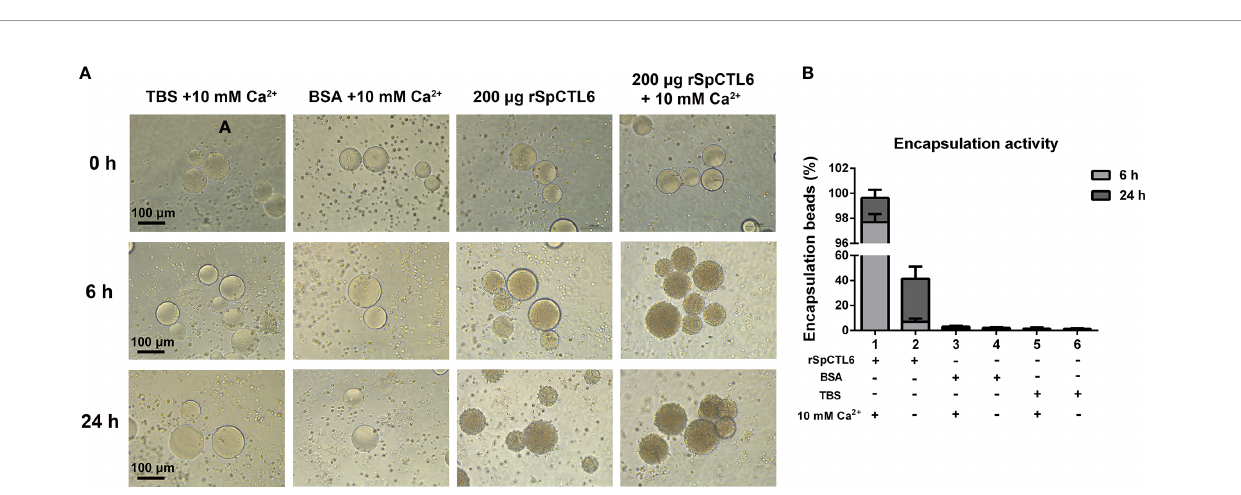
FIGURE 5 | Analysis of encapsulation activity of rSpCTL6. The agrose beads pre-coated with rSpCTL6 were observed for encapsulation by crab hemocytes at 0, 6 and 24 h post-incubation (A) . The beads coated with TBS and BSA were used as control groups. (B) The percentage of beads encapsulated by hemocytes after 6 h and 24 h of